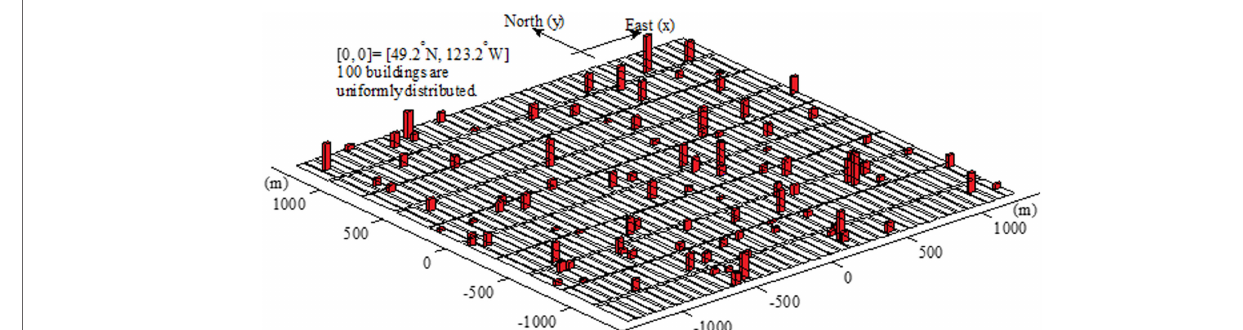
FIGURE 3 | Sites for the portfolio of 100 hypothetical buildings.